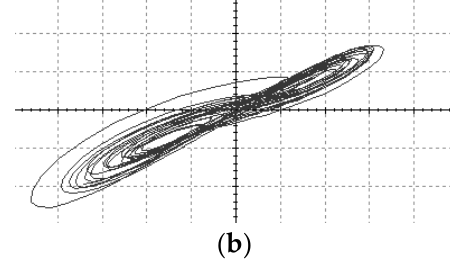
Figure 11. Two-dimensional planar projection of chaotic time-delay system. ( a ) V y - V z (0.5 V/div, 1 V/div); ( b ) V x - V y (1 V/div, 2